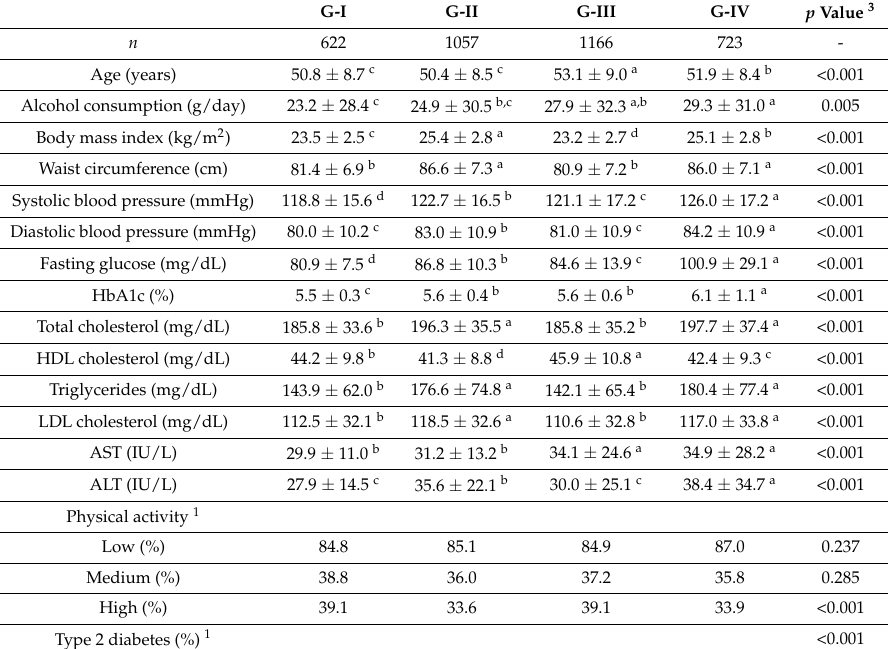
Table 3. General and clinical characteristics by β -cell function and insulin sensitivity in